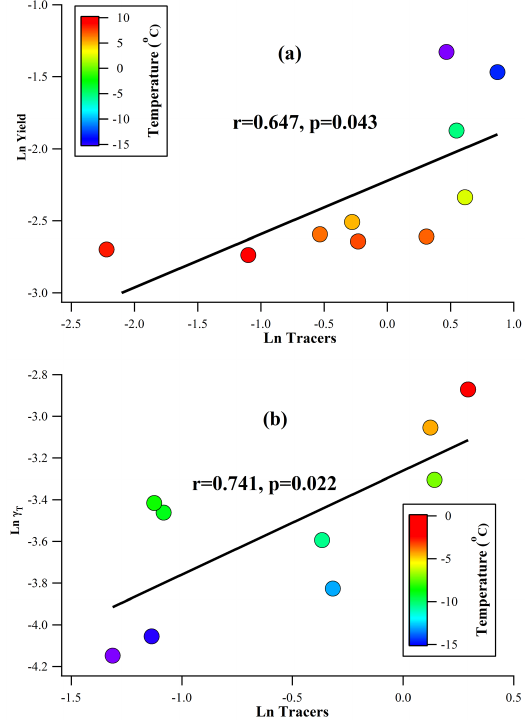
Figure 5. Correlation of SOA M tracers with SOA yield in period 1 (a) and γ T in period 2 (b)